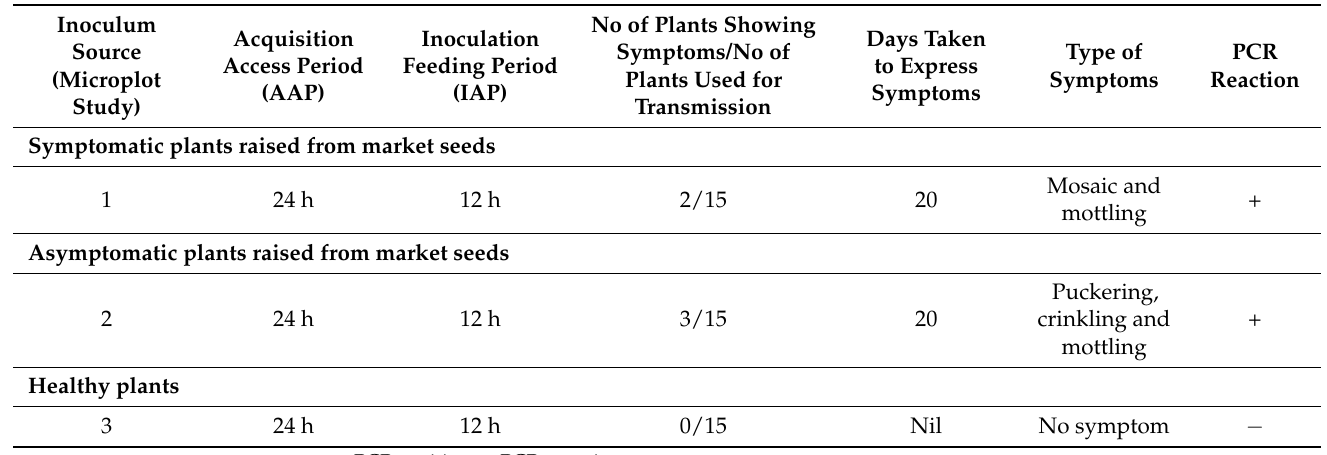
Table 5. Transmission of the begomovirus (ToLCNDV) to bitter gourd seedlings using Bemisia tabaci .